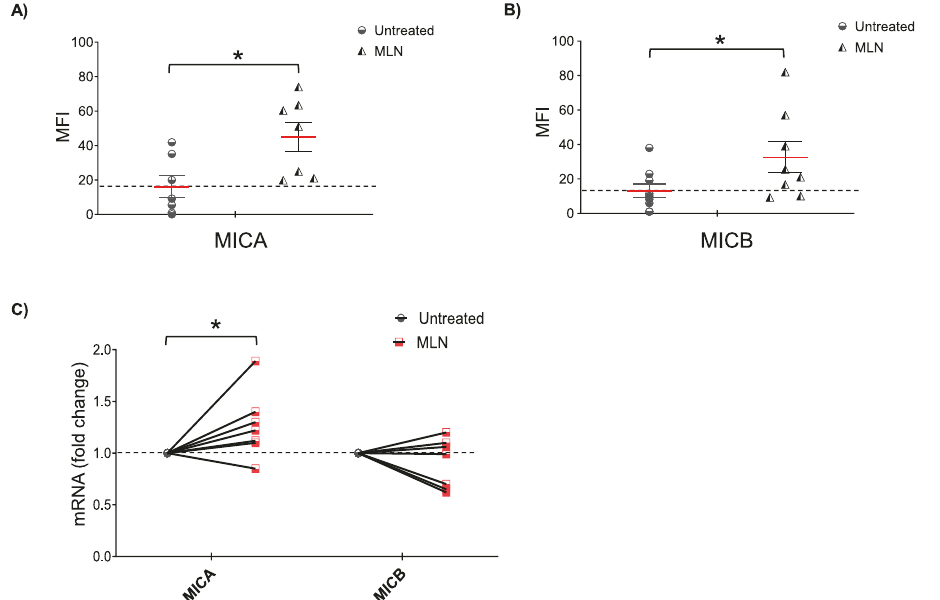
Fig. 3 Upregulation of MICA and MICB expression on patient-derived PCs upon MLN4924 treatment. A , B MICA and MICB cell surface expression was analyzed by fl ow cytometry on patient-derived MM cells treated with 400 nM MLN4924 for 72 h. Histograms represent the average of the mean fl uorescence intensity (MFI) values of the indicated ligand (with treatment-speci fi c isotype control MFI subtracted out). The MFI of MICA and MICB were calculated based on at least four independent experiments and statistical signi fi cance was evaluated (±SEM) by paired Student t test (* P < 0.05). C ) Real-time PCR analysis of total mRNA extracted from puri fi ed CD138 + cells untreated or treated with MLN4924 as described above for 48 h in complete medium supplemented with 20 ng/ml IL-3 and 2 ng/ml IL-6. Data, expressed as fold change units, were normalized to GAPDH and were referred to the untreated sample considered as calibrator (* P < 0.05). Myeloma cells were selected using anti-CD138 magnetic beads and more than 95% of the puri fi ed cells expressed CD138 and